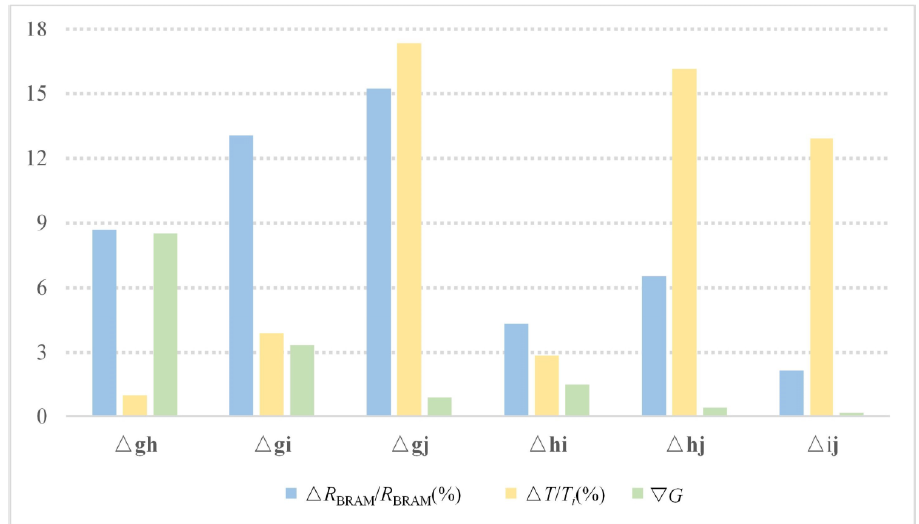
Figure 7.  G of matrix transposition schemes under the condition of c`. Figure 7. ∇ G of matrix transposition schemes under the condition of c‘ .